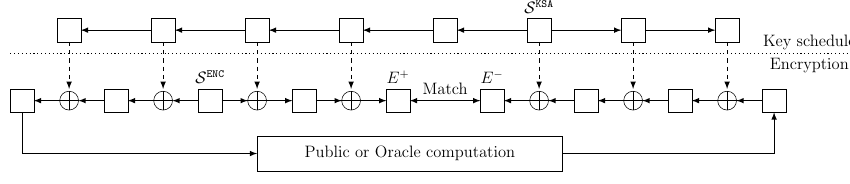
Figure 1: A high-level overview of the MITM attacks [DHS +